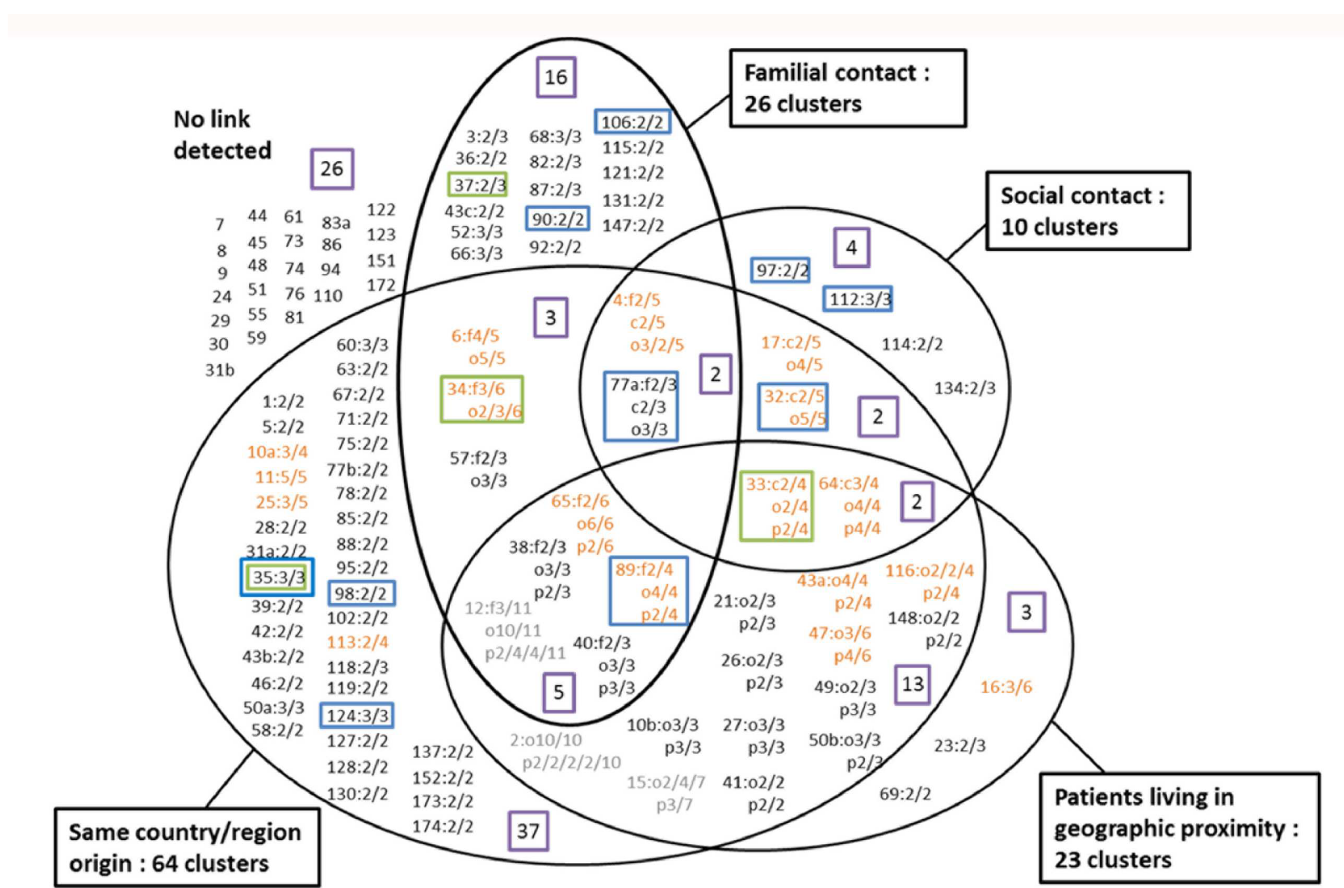
Fig 1. Repartition of the clusters according to the links identified between the patients. Clusters are representedby uniqueidentification numbers. Next to the cluster number, the numberof patients for who an epidemiologicallink was detected is indicated(i.e. 2/3: two of the three patients includedin the cluster present this link). f: familial link; o: same geographic origin; p: geographicproximity. Clusters in orangecontain more than 3 patients and cluster in grey more than 6. The purpleboxes indicate the numberof clusters belongingto each category (or combination of categories) of links. The blue boxes indicate clusters comprisingexclusively Belgian-born patients. The green boxes indicate clusters with strains presentingthe 776000000000171spoligotype (S-family).